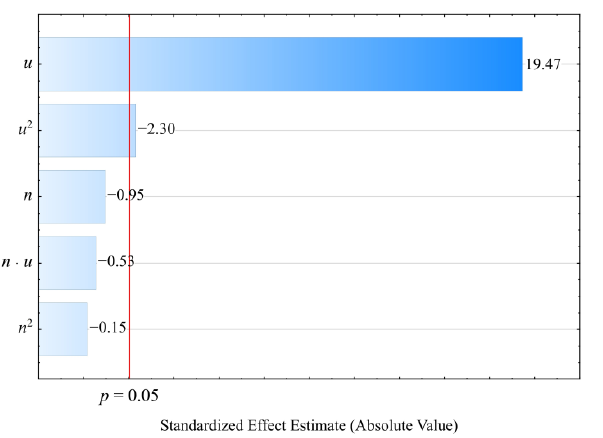
Figure 16. Pareto charts of the standardized effects for the empirical full model H ; the vertical line in the plot corresponds to the arbitrarily chosen level of significance ( p = 0.05).